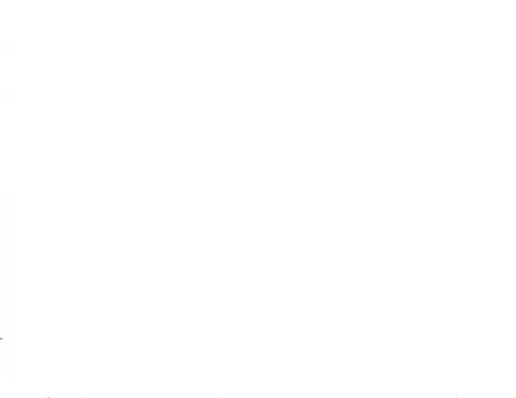
Figure 2. Total compounds quantified by means of colorimetric analysis in PCP1, PCP2 and PCP3. ( A ). Total polyphenols. ( B ). Total tannins. ( C ). Total anthocyanins. Statistical differences: (* p < 0.05), (** p < 0.01).